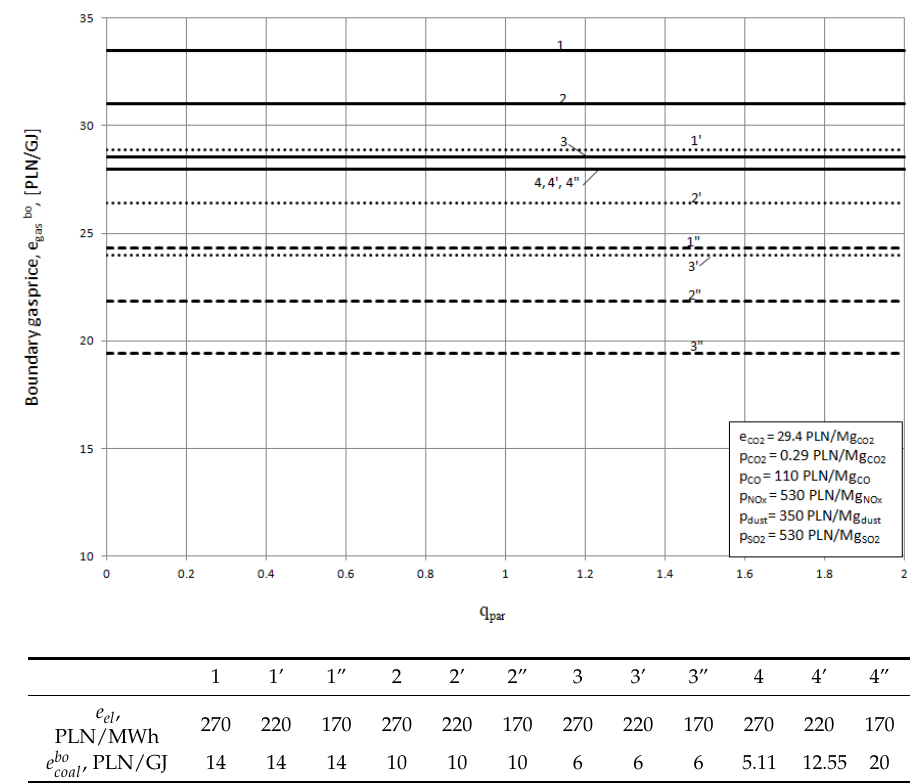
Figure 6. Theboundarypriceofgas e bo gas inthefunctionof q par withtheboundarypriceofcoal e bo